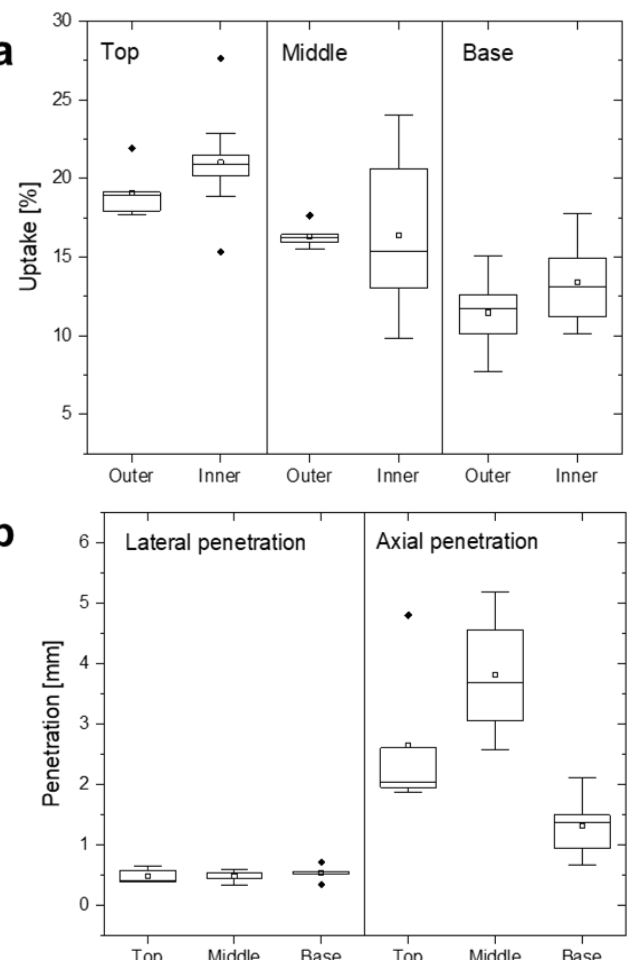
Figure 2. ( a , b ) Solution uptake and penetration depth of colored liquid in Gmelina arborea wood. The interpretation of the box plot is as follows: the centre line = the median, open square = the mean, box length = 25th to 75th percentile, whiskers 5th to 95th percentile, the black rhombus are the outliers. Table 2. Mean values for solution uptake and penetration of colored liquid into Gmelina arborea wood (standard deviation in parenthesis) along the stem height and across stem diameter.